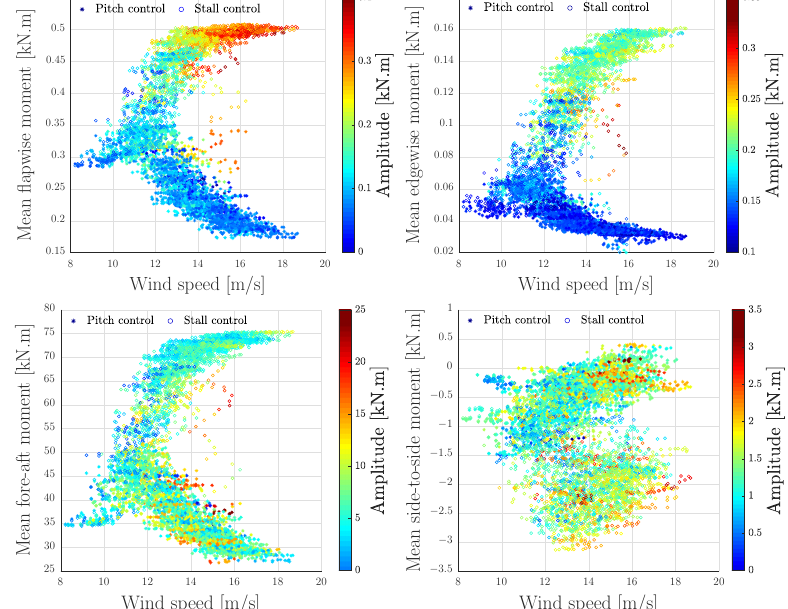
Figure 14. Comparison of the fatigue loads on the structure of the SWRT wind turbine operating with pitch-to-stall and pitch-to-feather control in the turbulent